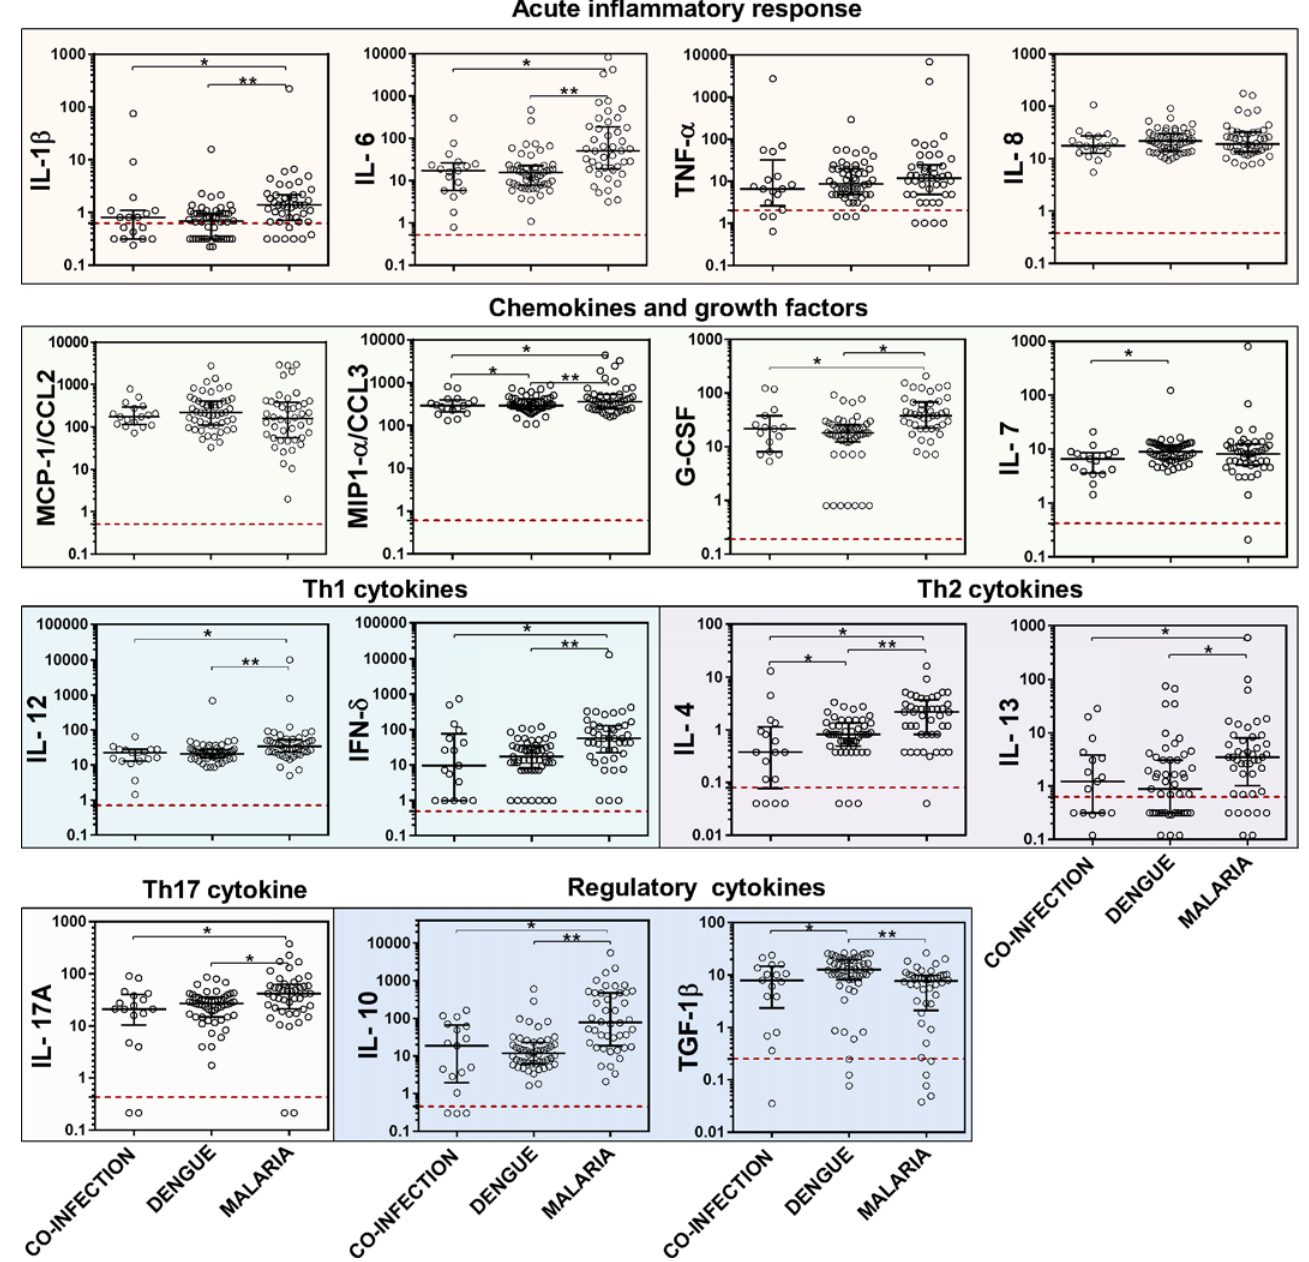
Fig 1. Serum levels of immune markers among patients with Plasmodium /DENV co-infection, DENV mono-infection, and Plasmodium mono- infection. Serum levels were analyzed by 17-plex cytokine array (Biorad Laboratories) for all immune markers except TGF- β 1, which was measured by an R&D Systems ELISA kit. Three immune markers were excluded (GM-CSF, IL-5, and IL-2) from this analysis because more than 25% of the values fell below the limit of detection of the assays. Horizontal bars represent group median and inter-quartile range. Red dotted lines show lower limit of detection for each immune marker. Units on the y-axis are log 10 transformed scales of analyte concentration in ng/mL for all immune markers except for TGF- β 1, which is represented in μ g/mL. * p < 0.05 for group comparison by the Kruskal-Wallis test followed by post-hoc Dunn ’ s pair-wise comparison.